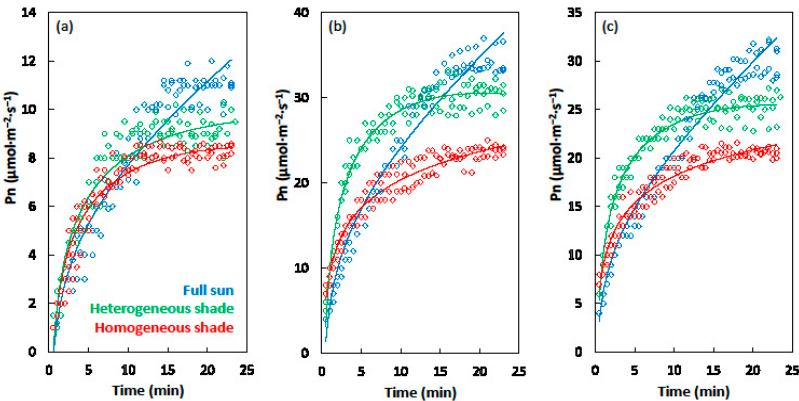
Figure 4. The increase in the net CO 2 assimilation (Pn) immediately following the supply of the photosyntheticphotonfluxdensityof800 µ mol · m − 2 · s − 1 totheleavesof( a ) Cycasmicronesica , ( b ) Zeamays , and ( c ) Glycine max . For each species, the leaves were grown in homogeneous 62% sunlight exclusion under a shade screen, heterogeneous 62% sunlight exclusion under a slat-house, or full sunlight. The models for each species were: ( a ) Full sun: Pn = 0.97 + (0.20 × time) + (2.05 × log(time));